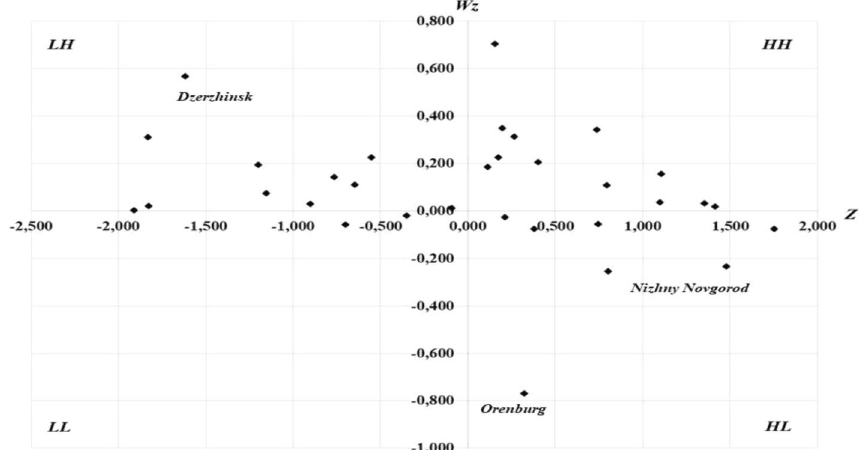
Fig. 4 Moran’s spatial scatter diagram (population density) for cities of the Volga Federal District of Russia in 2017 (Russian regions. Main social and economic parameters of cities. 2018 // Federal Service of State Statistics [Electronic resource] http:// www. gks. ru/ free_ doc/ doc_ 2018/ region/ reg- gor18. pdf (date of application